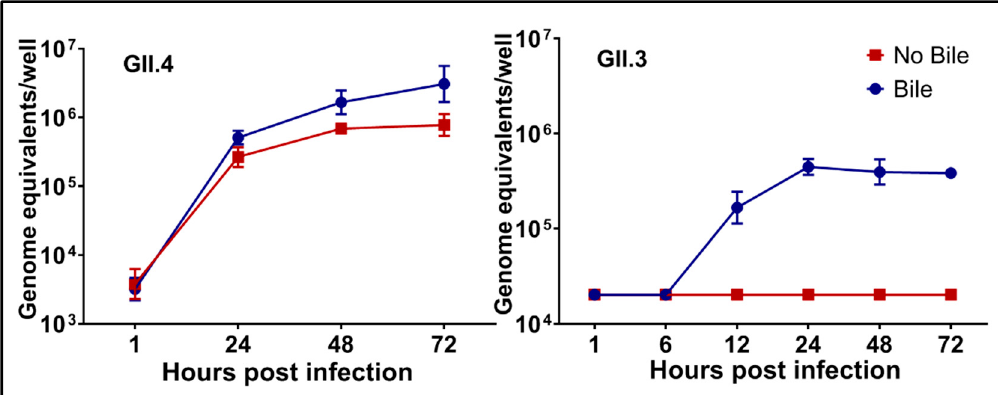
Figure 2. There are strain-specific requirements for human norovirus (HuNoV) replication. Replication of GII.4 / Sydney / 2012-like virus occurs in the absence of exogenously added human bile but it is enhanced by bile while bile is essential for replication of a GII.3 HuNoV strain. Virus growth curves show RNA replication can be detected by 12 h post-infection and replication plateaus by 48 h post-infection. Error bars denote standard deviation. (From [52]).